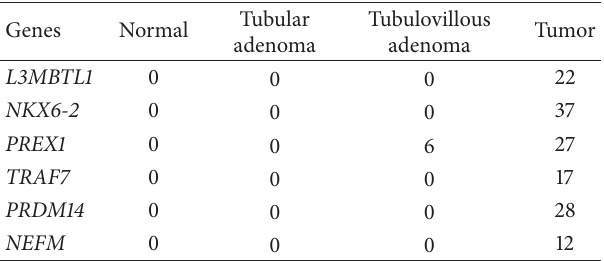
Table 4: (a) Significant regulators identified by IPA. (b) Genes’ mapping to known molecular